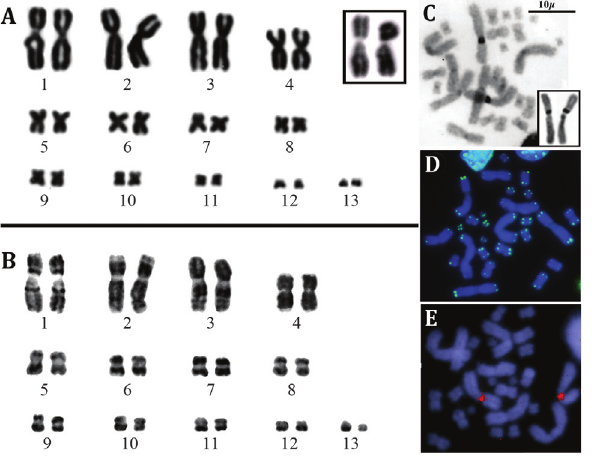
Figure 1 - Karyotype (A and B) and metaphases (C-E) of Peltocephalus dumerilianus, 2n = 26 and FN = 52. (A) Conventional staining. Inset, pair 1 from other metaphase showing the conspicuous secondary constriction. (B) GTG-banding pattern. (C) CBG-banding pattern. Note the conspicu- ous C-positive bands on pair 1. Inset, pair 1 bearing positive Ag-NORs. Scale bar = 10 (cid:2) m. (D) FISH with telomeric probes. Positive signals (green) are seen at the termini of all chromosomes. (E) Mapping of 45S rDNA.PositiveFISHsignals(red)areatthesecondaryconstrictionregion of pair